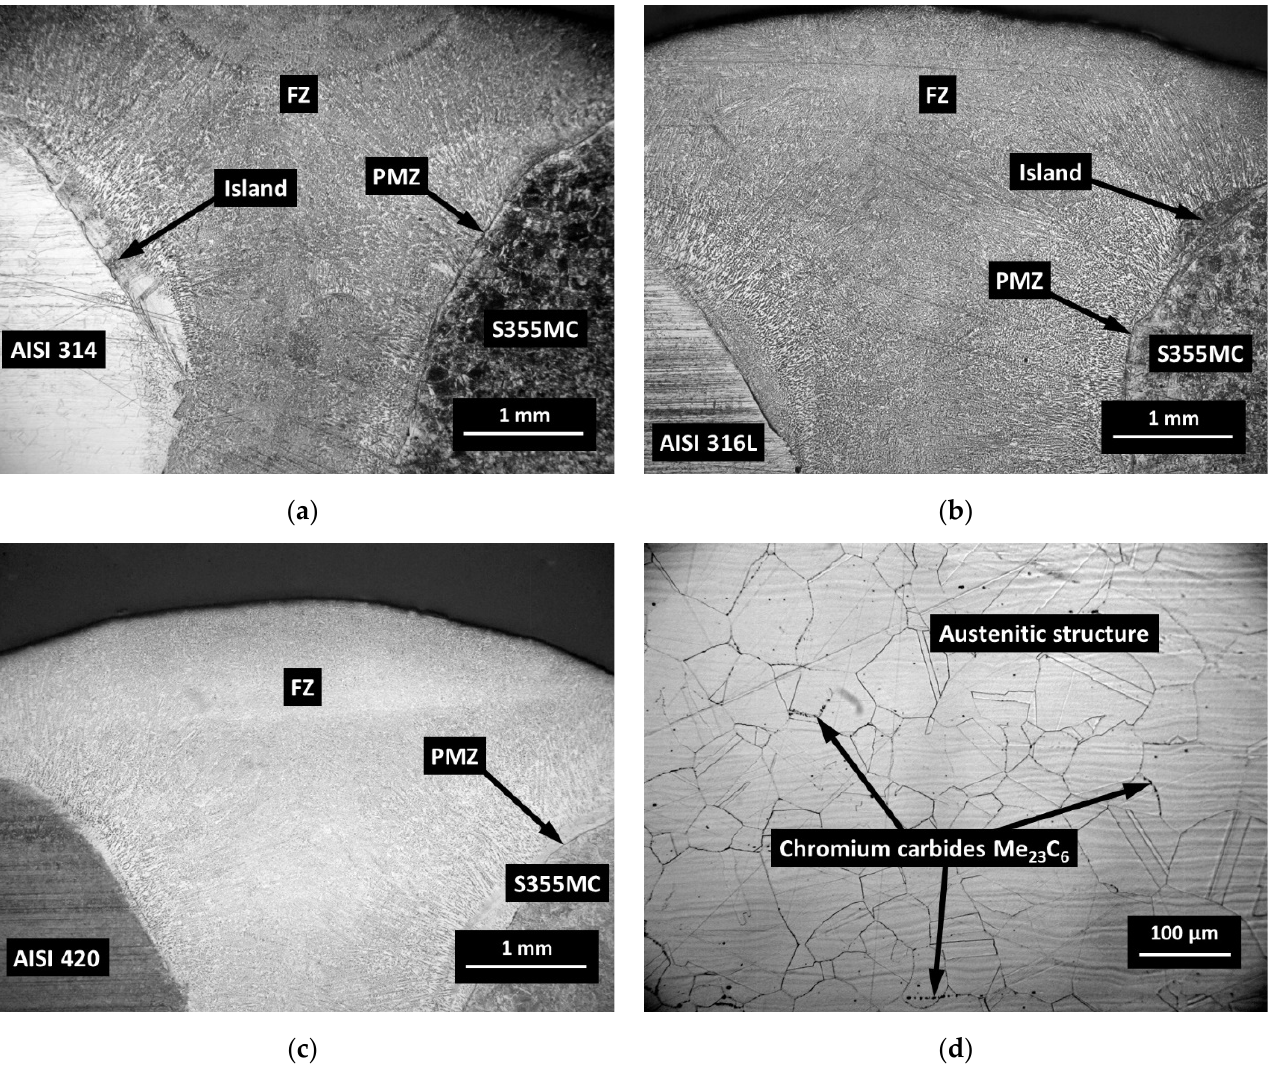
Figure 7. Optical images of dissimilar welds: ( a ) AISI 314/S355MC; ( b ) AISI 316L/S355MC; ( c ) AISI 420/S355MC; and ( d ) austenite grains in AISI 314.